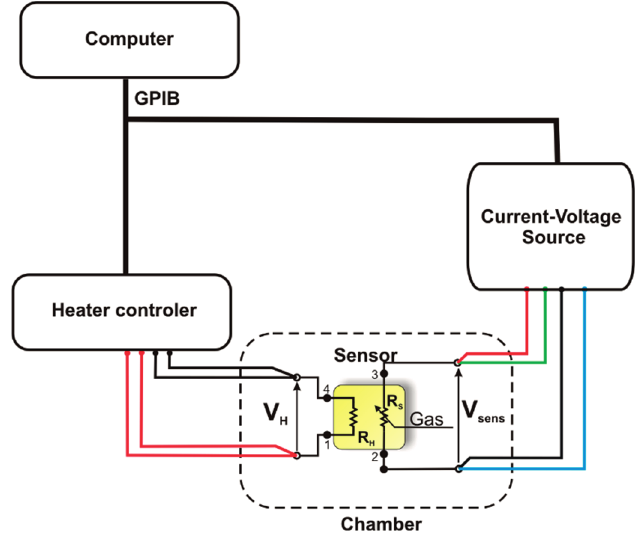
Figure 2. Schematic diagram of the construction of a measuring test stand used during the characterisation of sensors using the Temperature-Stimulated Conductance method and the techniques of